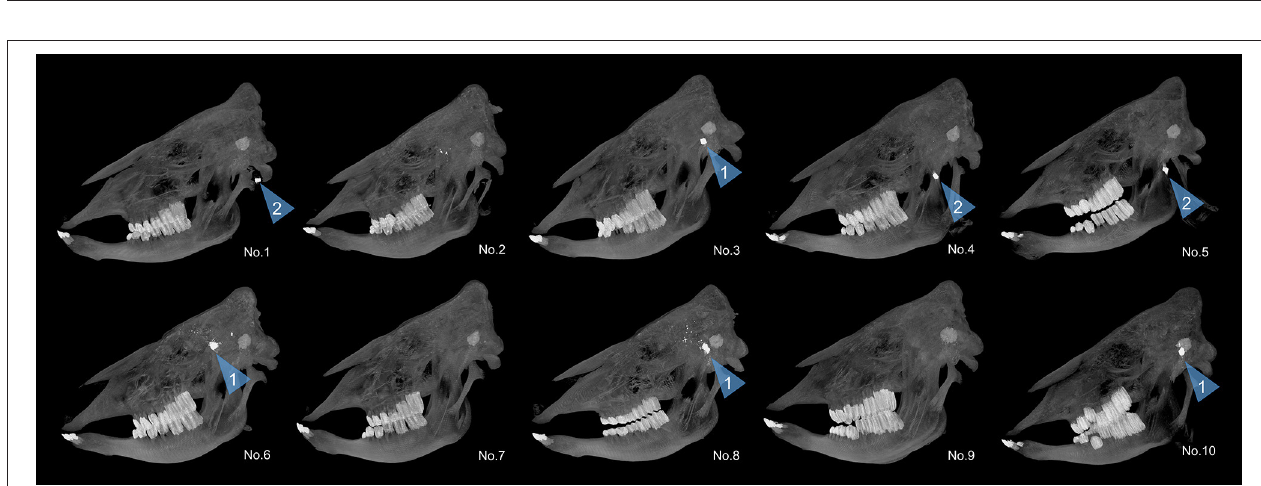
FIGURE 3 | Maximum intensity projection of heavy cattle skulls in the .357 MAG FTX ® group in sagittal view to demonstrate bullet fragmentation and distribution of fragments inside the cranial cavity.